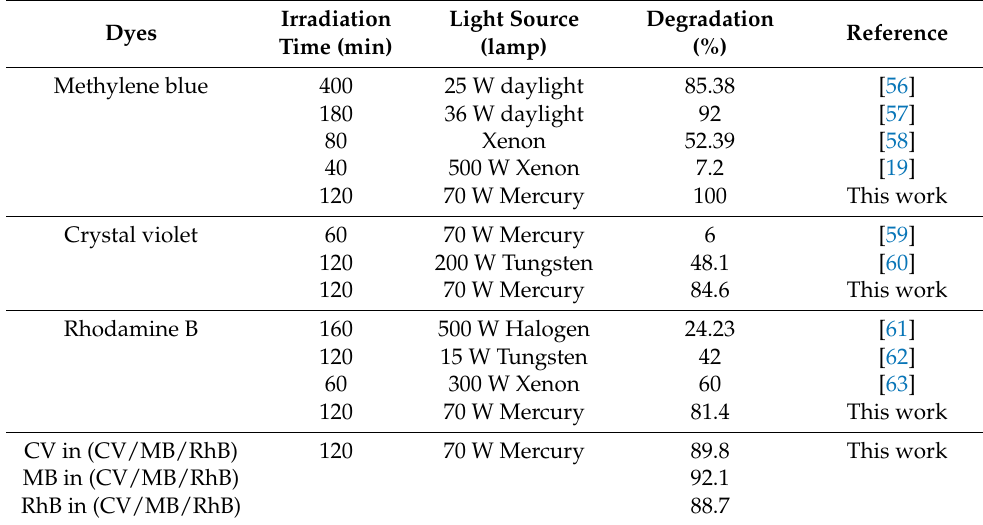
Table 1. Degradation of organic dyes using copper sulfide as photocatalyst.